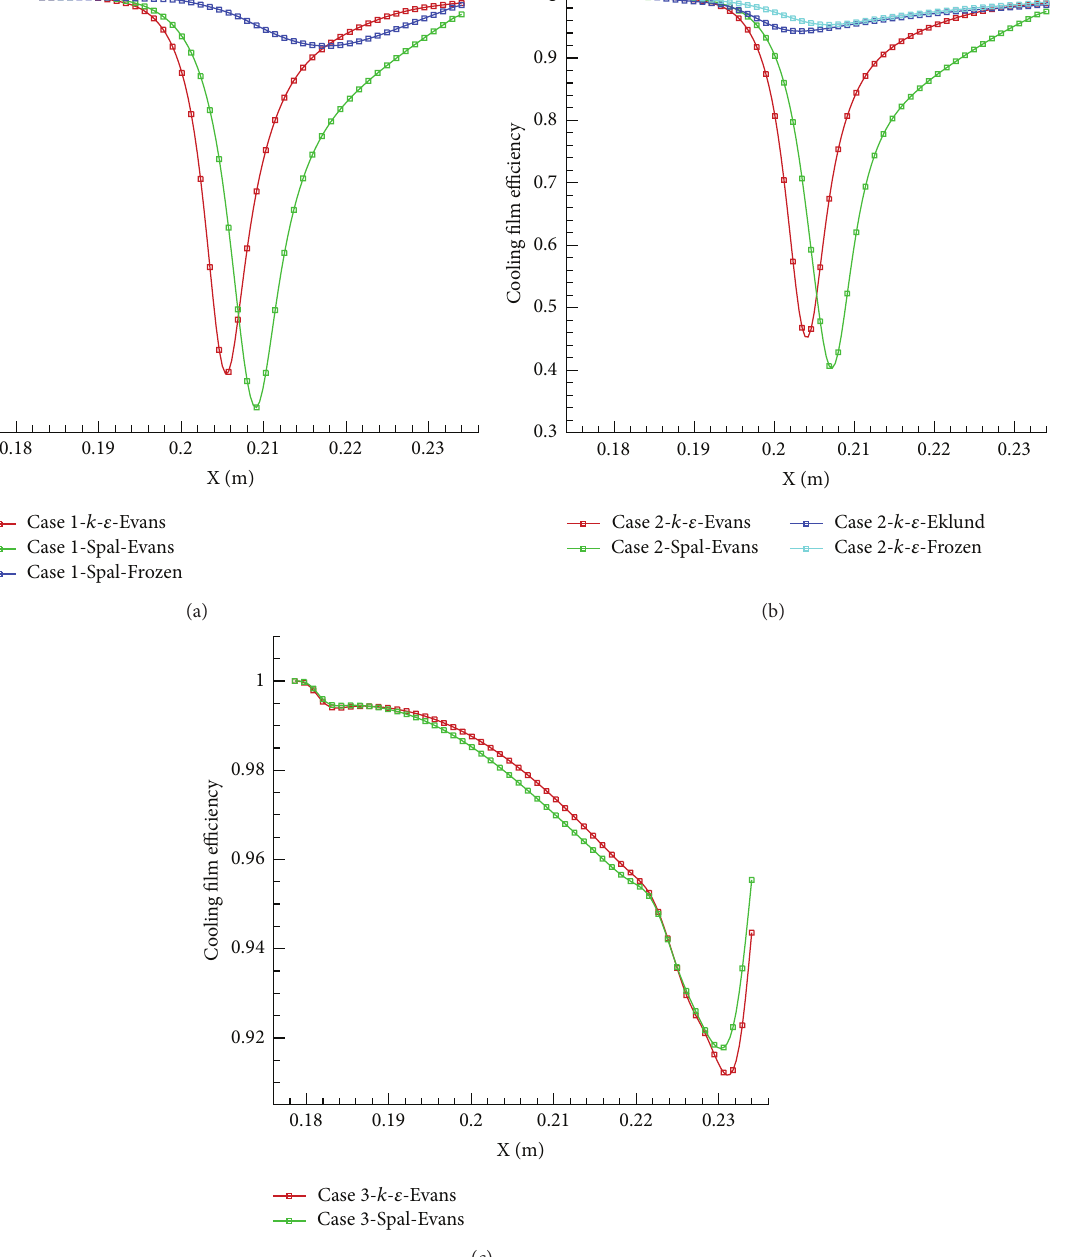
Figure 12: Cooling film efficiency as function of distance from the injection slot for (a) Case 1, (b) Case 2, and (c) Case